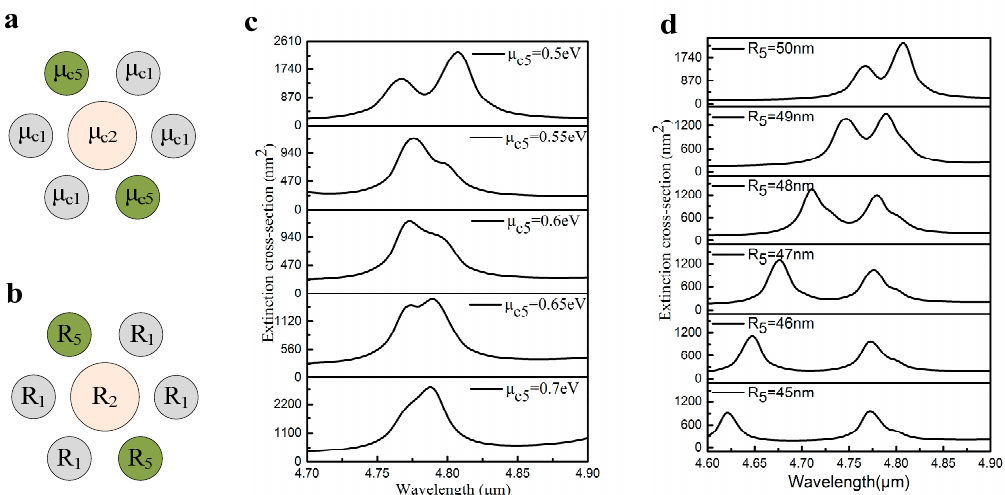
Figure 7. ( a ) The chemical potentials of the upper left nanodisk and the lower right nanodisk are labeled as µ c 5 . ( b ) The distribution of di ff erent radii in heptamer radius. ( c ) The extinction spectra with the change of chemical potential. ( d ) With the decrease of radius, the values of the two plasmonic resonance peaks gradually decrease.